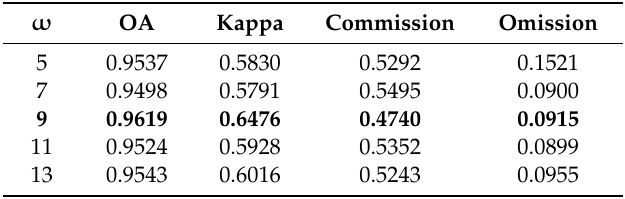
Table 7. Accuracy under di ff erent patch sizes on the third